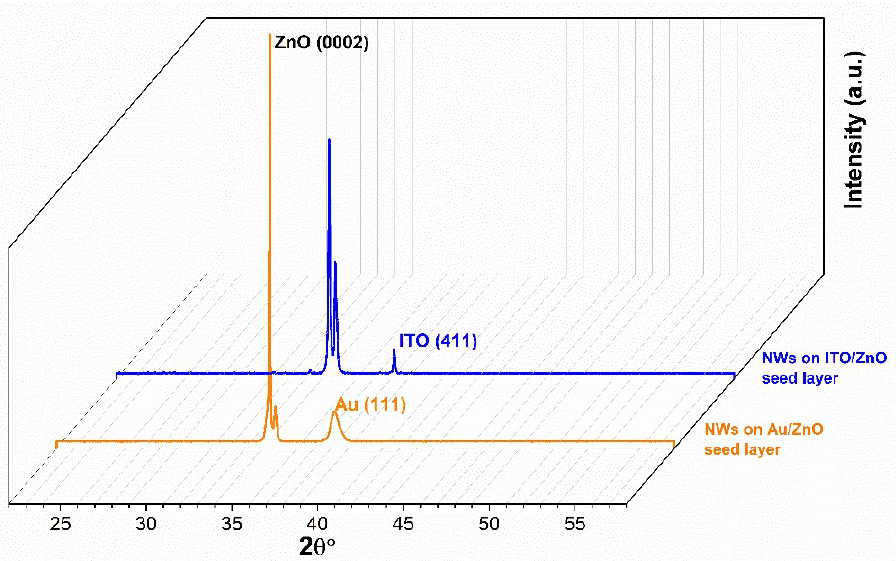
Figure 6 . XRD 3D spectra of the ZnO NWs deposited on Au/ZnO and ITO/ZnO seed layer struc- Figure 6. XRD 3D spectra of the ZnO NWs deposited on Au/ZnO and ITO/ZnO seed layer tures.